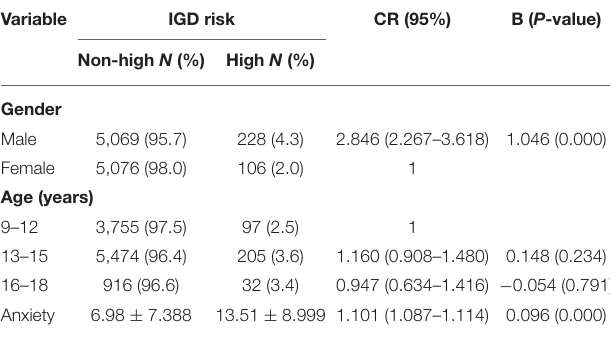
TABLE 5 | Differences in risk of IGD among different gender, age and anxiety.